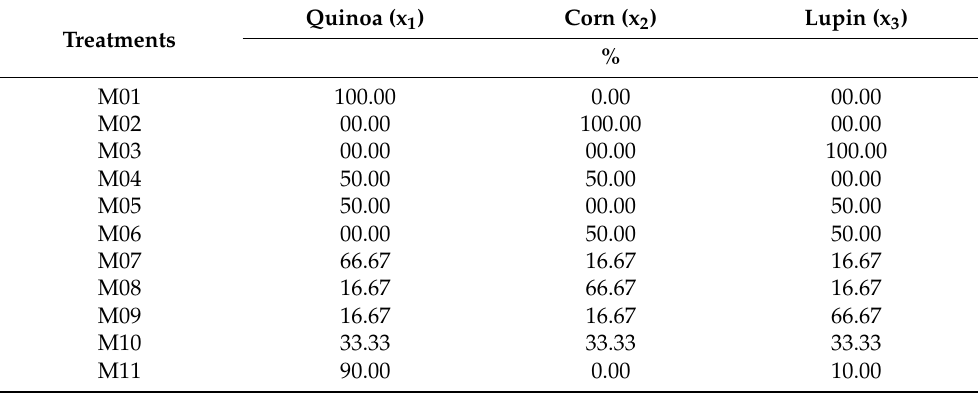
Table 1. Augmented simplex mix